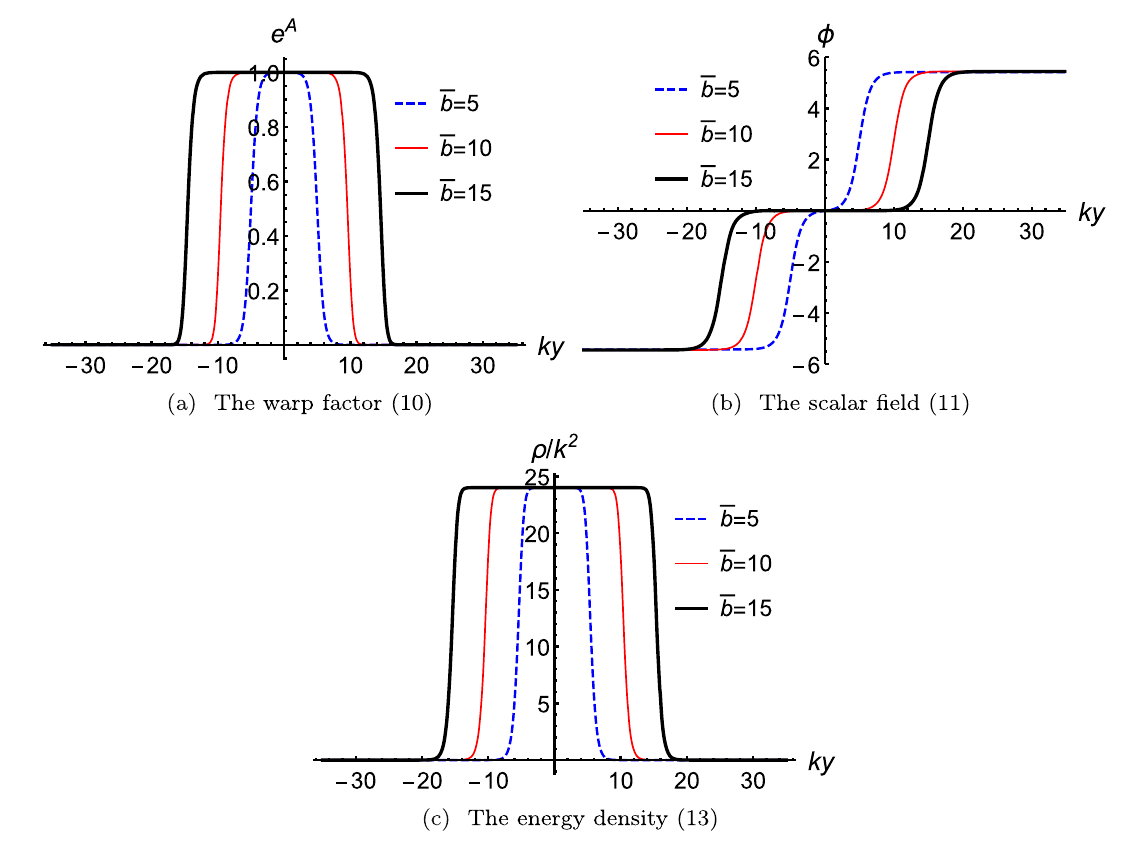
Fig. 1 The shapes of the warp factor (10), scalar field (11), and energy density